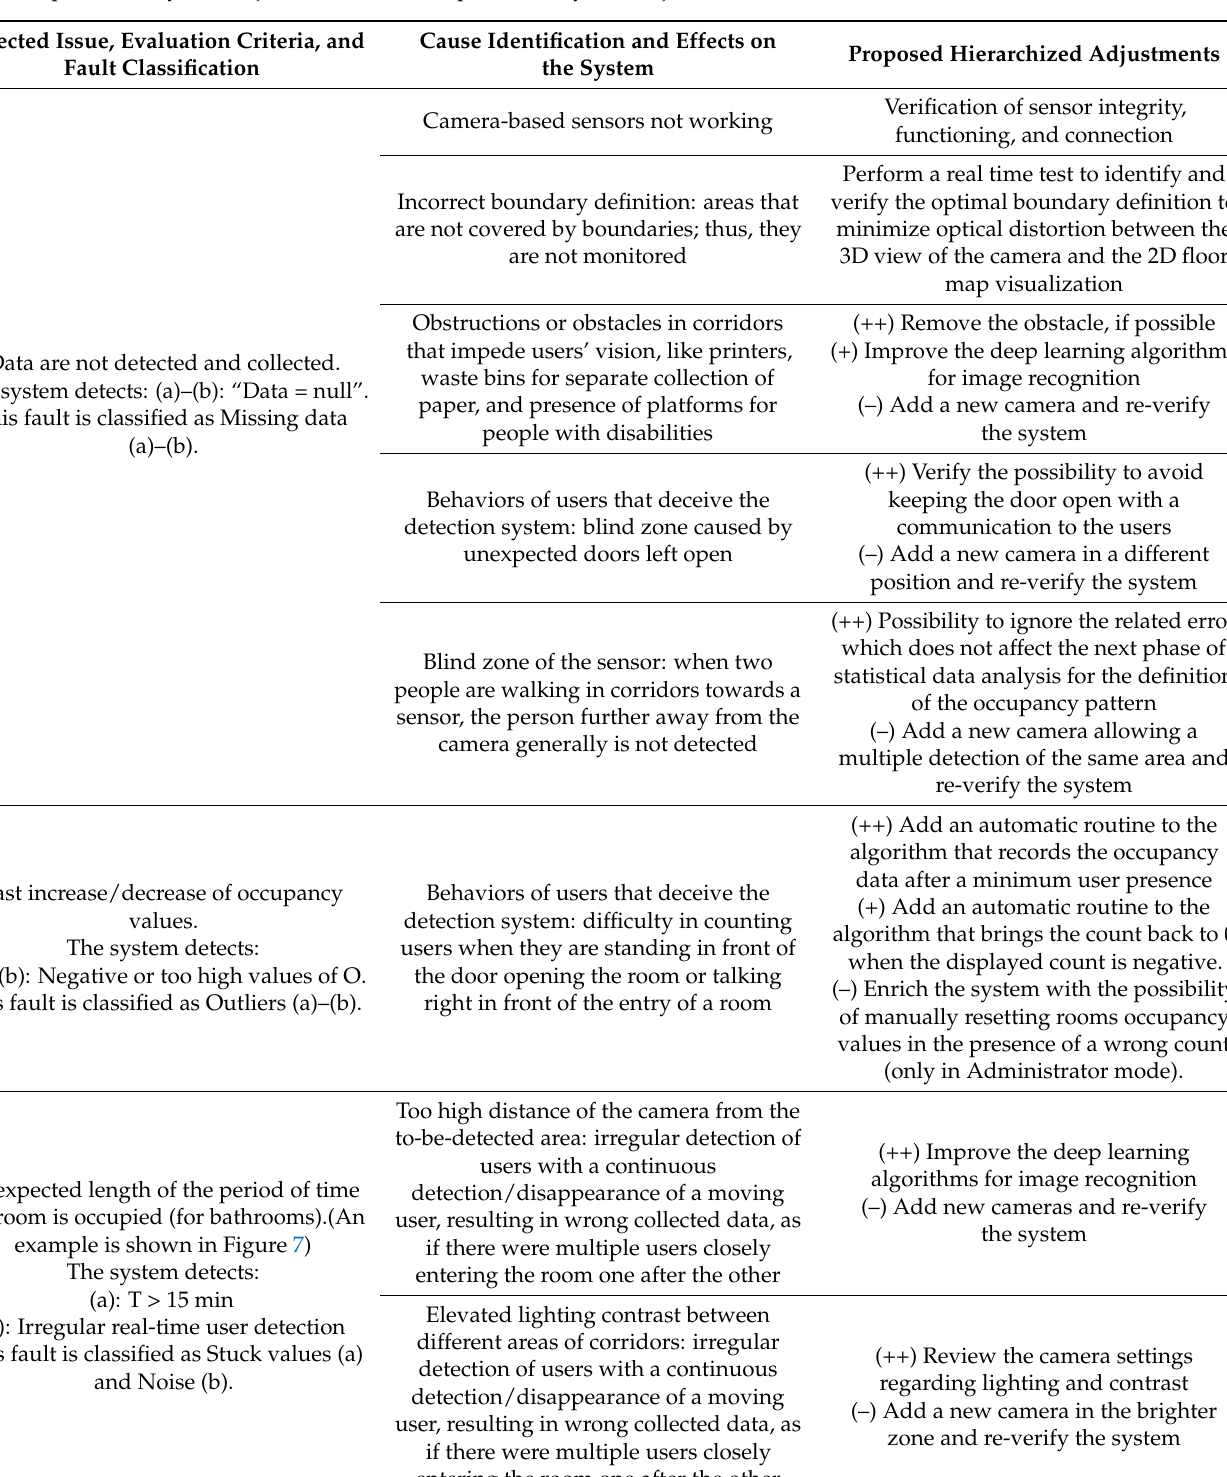
Table 4. Identified issues and effects on the data collecting system during the test campaigns. Table legend: (a): data collection phase; (b): real-time test campaign phase; O: occupancy values at room-level, number of people occupying the room (p); T: period of time in which users occupy a room (minutes/hours); adjustments hierarchy scale ranging from (++) most preferable system adjustment to (–) least preferable system